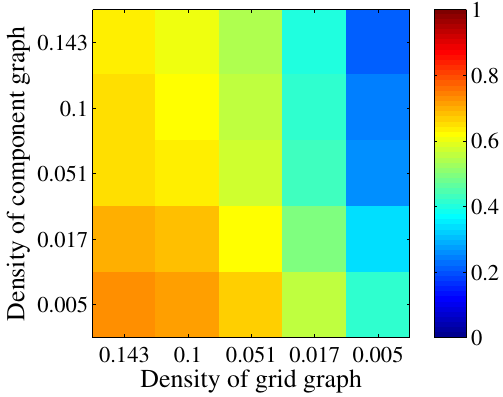
Fig. 2. Correlation coefficients between the time evolution of the applied thresholds for varying density of the RPCA graph (68 com- ponents) and grid-based graph with 2562 nodes.